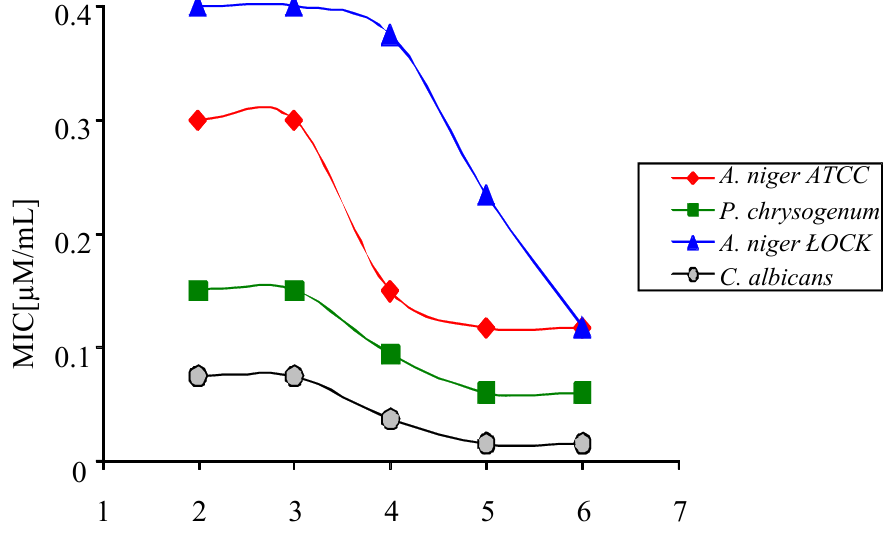
Figure 9 . The relationship between number of methylene groups in the spacer of polymethylene- α , ω -bis( N,N -dimethyl- N -dodecyloammonium bromides) 1-5 and MIC of conidia.